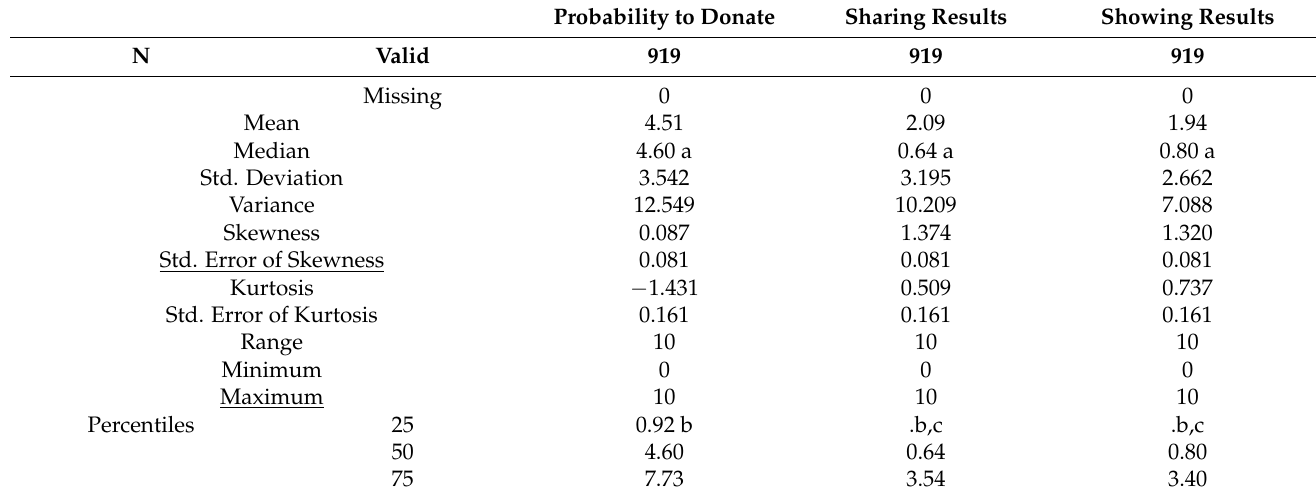
Table 1. Comparison of data donation willingness, data sharing and data showing behavior. Probability to Donate Sharing Results Showing